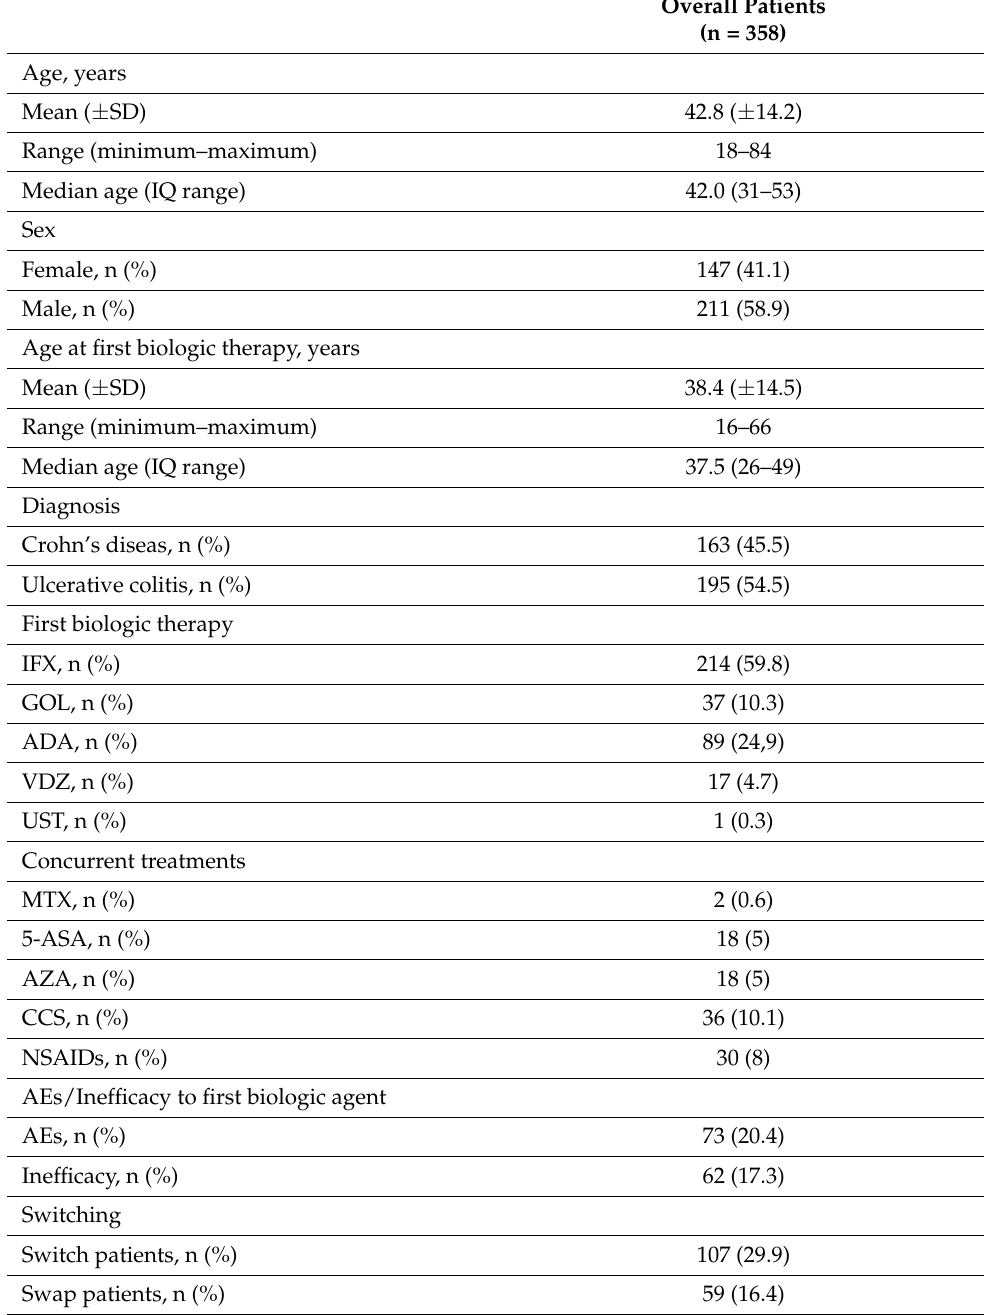
Table 1. Characteristics of the study